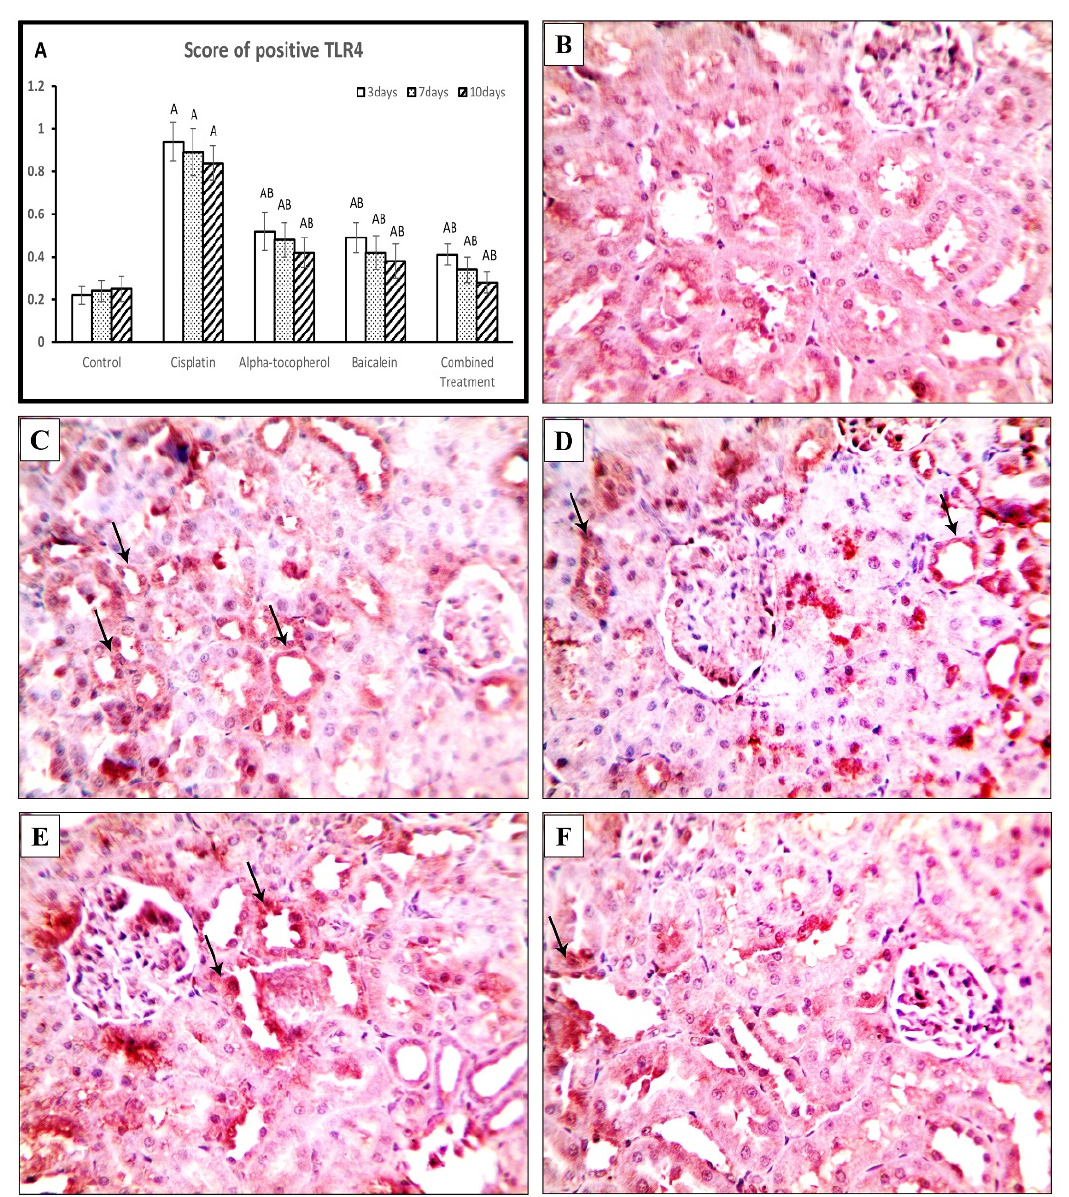
Figure 8. Microscopic pictures of adrenal sections immunostained against TLR4 from rat groups sacrificed after 10 days showing ( A ) positive cell score Significant vs. control group refers to A, while significant vs. (cisplatin, -tocopherol, and baicalein) treatment groups refers to (B, C, D), respectively, ( B ) control group, and ( C ) marked expression in positive brown tubular expression in Cis group. ( D ) The positive brown tubular expression slightly decreased in renal sections from the α -tocopherol group, ( E ) moderately decreased in renal sections from the baicalein group, and ( F ) significantly decreased in renal sections from the combined treatment group. Black arrows indicate a positive reaction. IHC counterstained with Mayer’s hematoxylin. High magnification ×: 400 bar 50. Similarly, the cisplatin group showed a significantly high cytoplasmic expression of TLR2 ( p < 0.01), which was attenuated by treatment with α -tocopherol, baicalein,